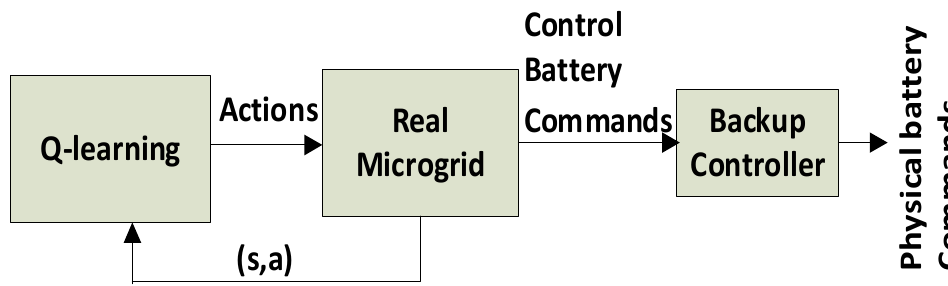
Figure 3. Online implementation of the RL algorithm.